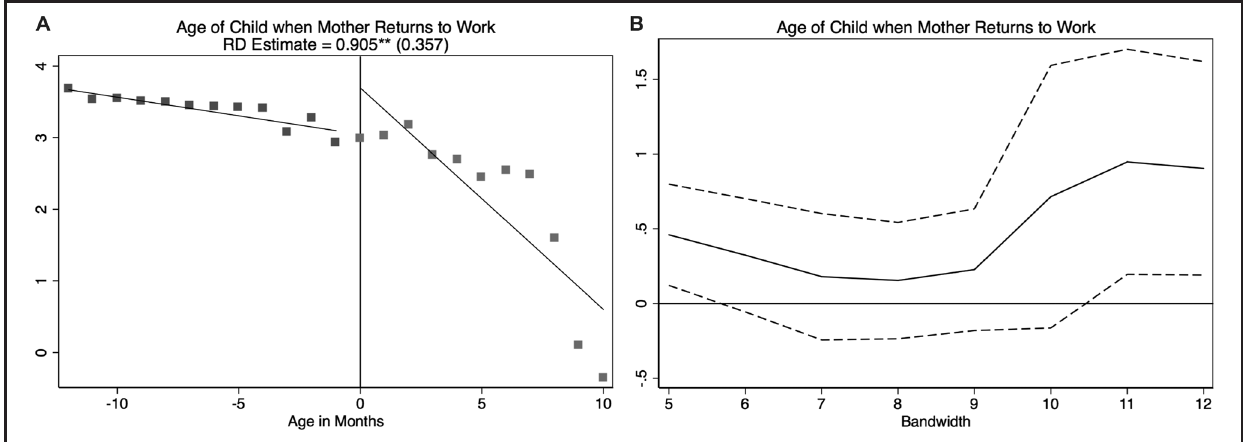
Average age of the child when the mother returned to work. (A) Each data point corresponds to the average value of each outcome by month of birth of the child in 1-month bins. The window includes all children born to mothers from January 2010 until November 2011. The vertical line denotes the PPL cutoff of January 1 2011, normalized to 0. (B) The equivalent coefficient estimates and associated 95% confidence intervals when equation 1 is estimated using 3, 4, ..., 12 month-of-birth cohorts on either side of the threshold.